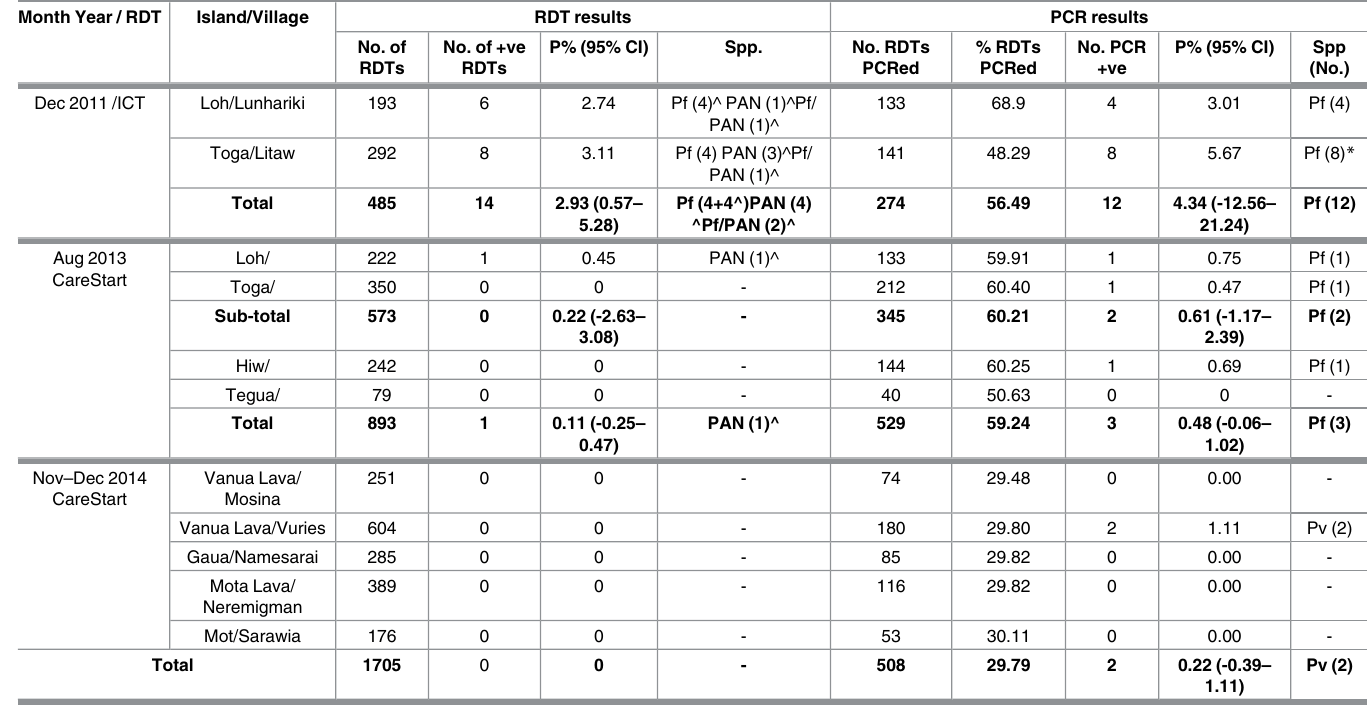
Table 2. Time, location, number of individuals tested and results of RDT and PCR from used-RDTs in Pro-ACDs conducted in Torba Province. Month Year /